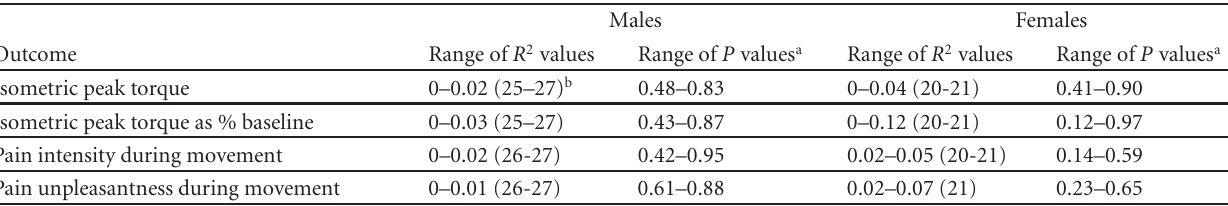
Table 2: Regression analyses of serum 25OHD concentrations versus pain and strength outcomes in participants two days after undergoing the eccentric exercise protocol.